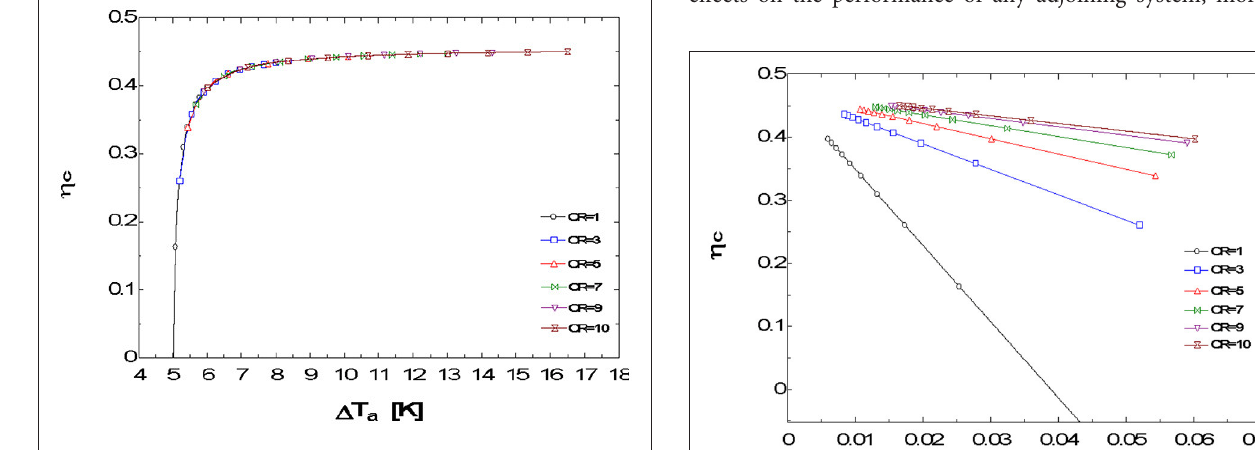
FIGURE 3 | Collector efficiency η c vs. temperature difference 1 T a at different concentration ratios.